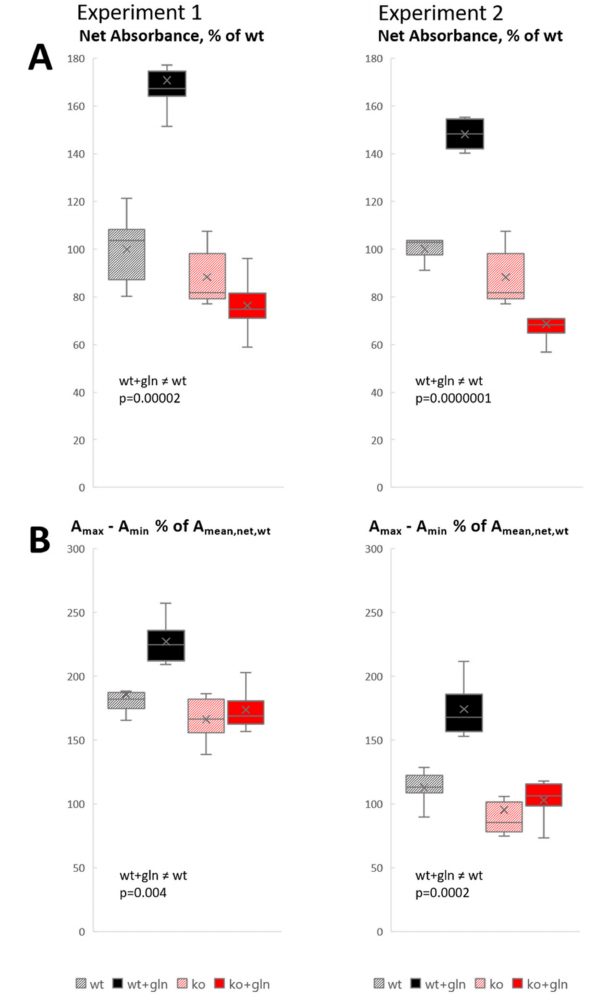
Figure 4. GABA synthesis in nerve endings is rescued by glutamine supplementation in Slc38a1 +/+